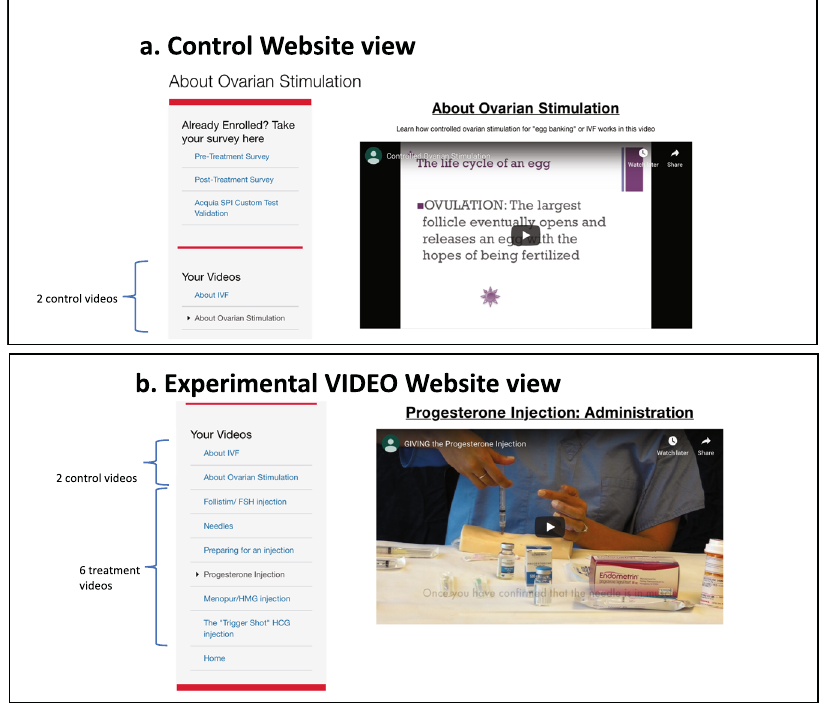
Fig. 2 LOVE study website. Screenshots of the online portal for the ( a ) control group and ( b ) experimental